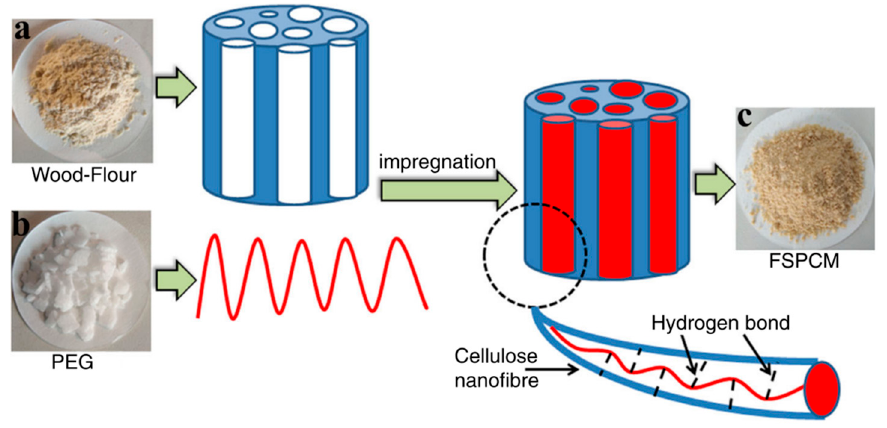
Figure 1. Preparation of composite PCMs with wood flour and PEG [40].